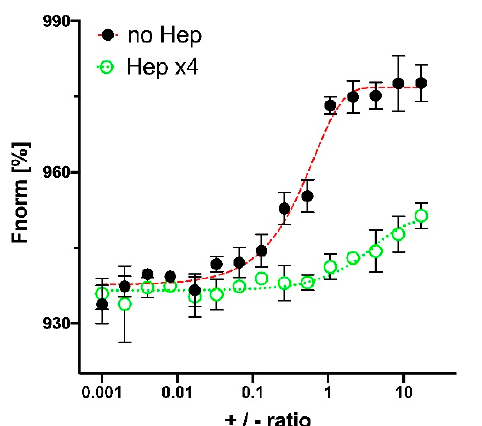
Figure 4. Effect of Hep excess on PLL-pDNA interaction studied by microscale thermophoresis method. +/ − charge ratio is determined by molar ratio of Lys–NH 3+ groups and PO 4 − groups of pDNA. Red line—interaction of PLL with pDNA. Green line—interaction of PLL with pDNA in the medium containing Hep excess over PLL ([SO 3 − ] / [Lys–NH 3 + ] = 4). PLL-FITC conjugate was used as target, which was titrated by ligand (pDNA = pCMVL) different concentrations.